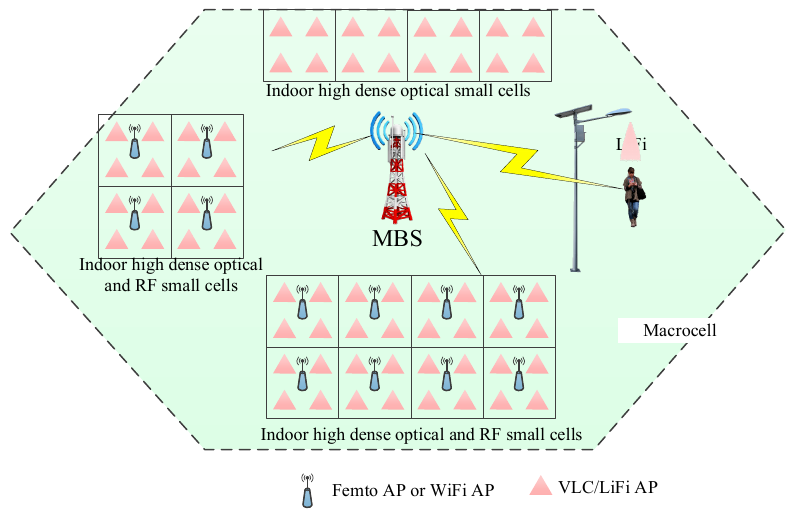
Figure 4. Scenario of heterogeneous multi-tier networks containing an RF macrocell, many RF small cells, and a large number of optical small cells.